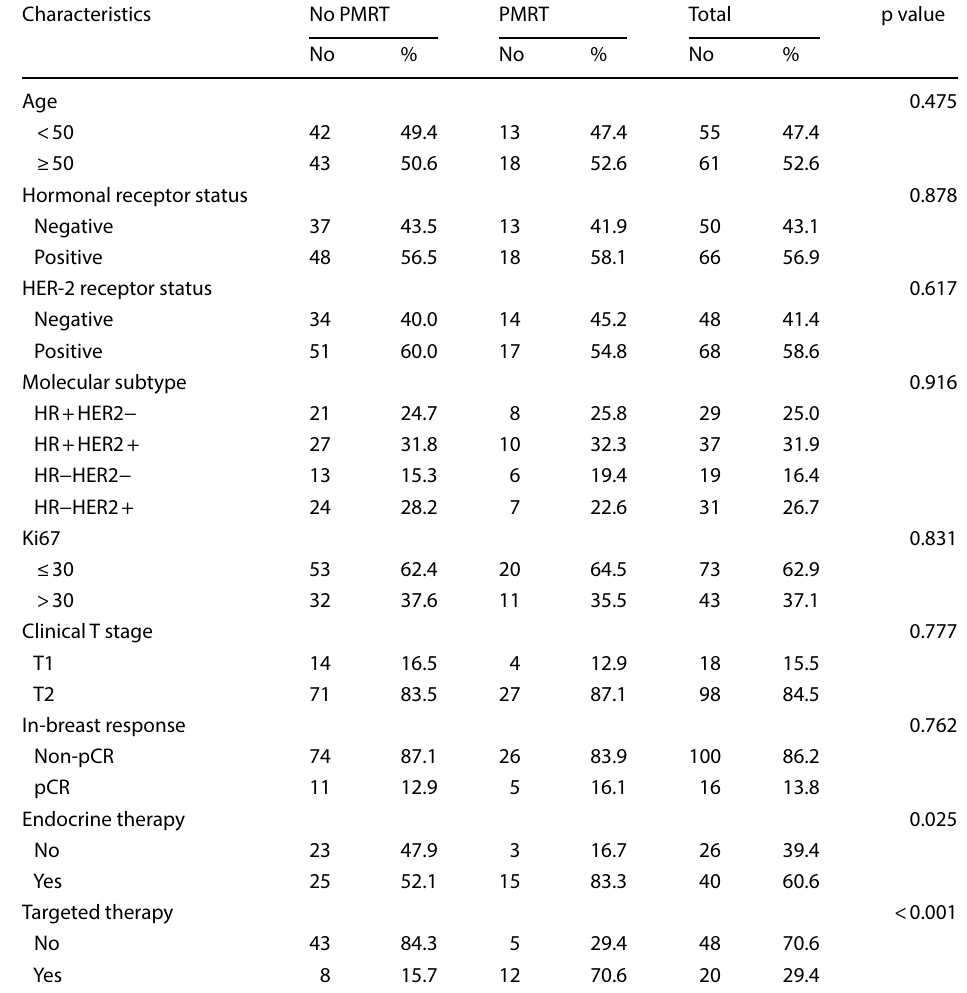
Table 1 Baseline characteristics of all patient